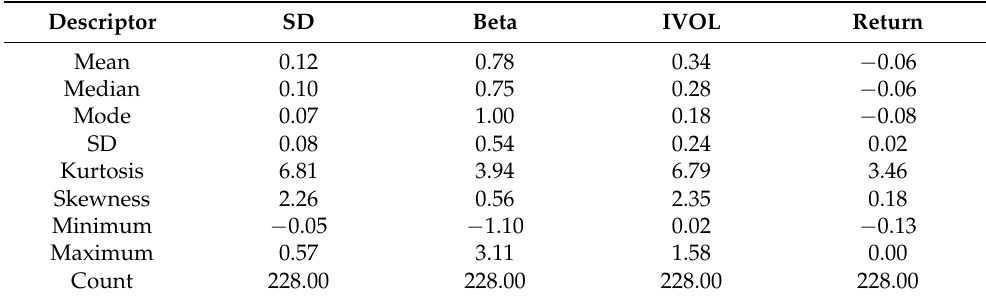
Table 1. Summary statistics for estimated standard deviation (SD), beta, average returns, and idiosyncratic volatility